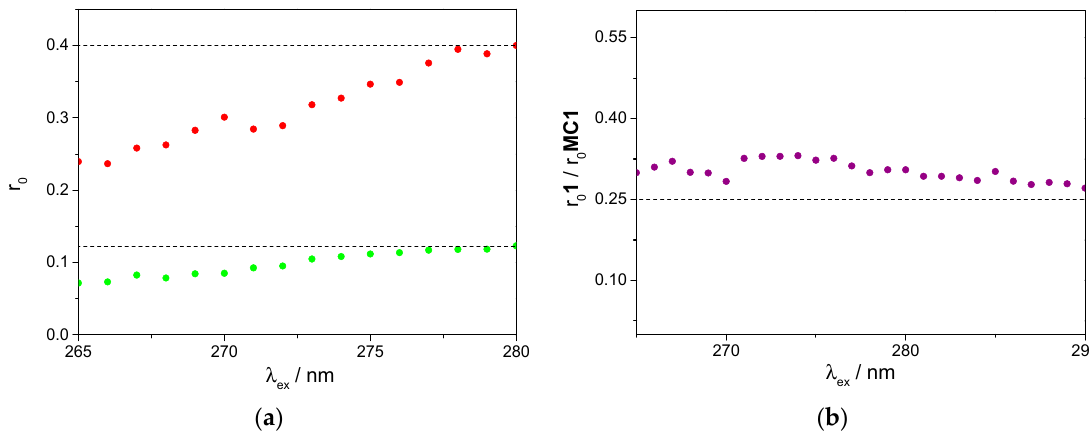
Figure 10. Fluorescence excitation anisotropy spectra of 1 (green) and A (red) in a Zeonex film at room temperature ( a ), and the respective anisotropy ratio ( b ), as a function of excitation wavelength. Slits were 8 nm for excitation and 14 nm for emission. λ ex = 270 nm.